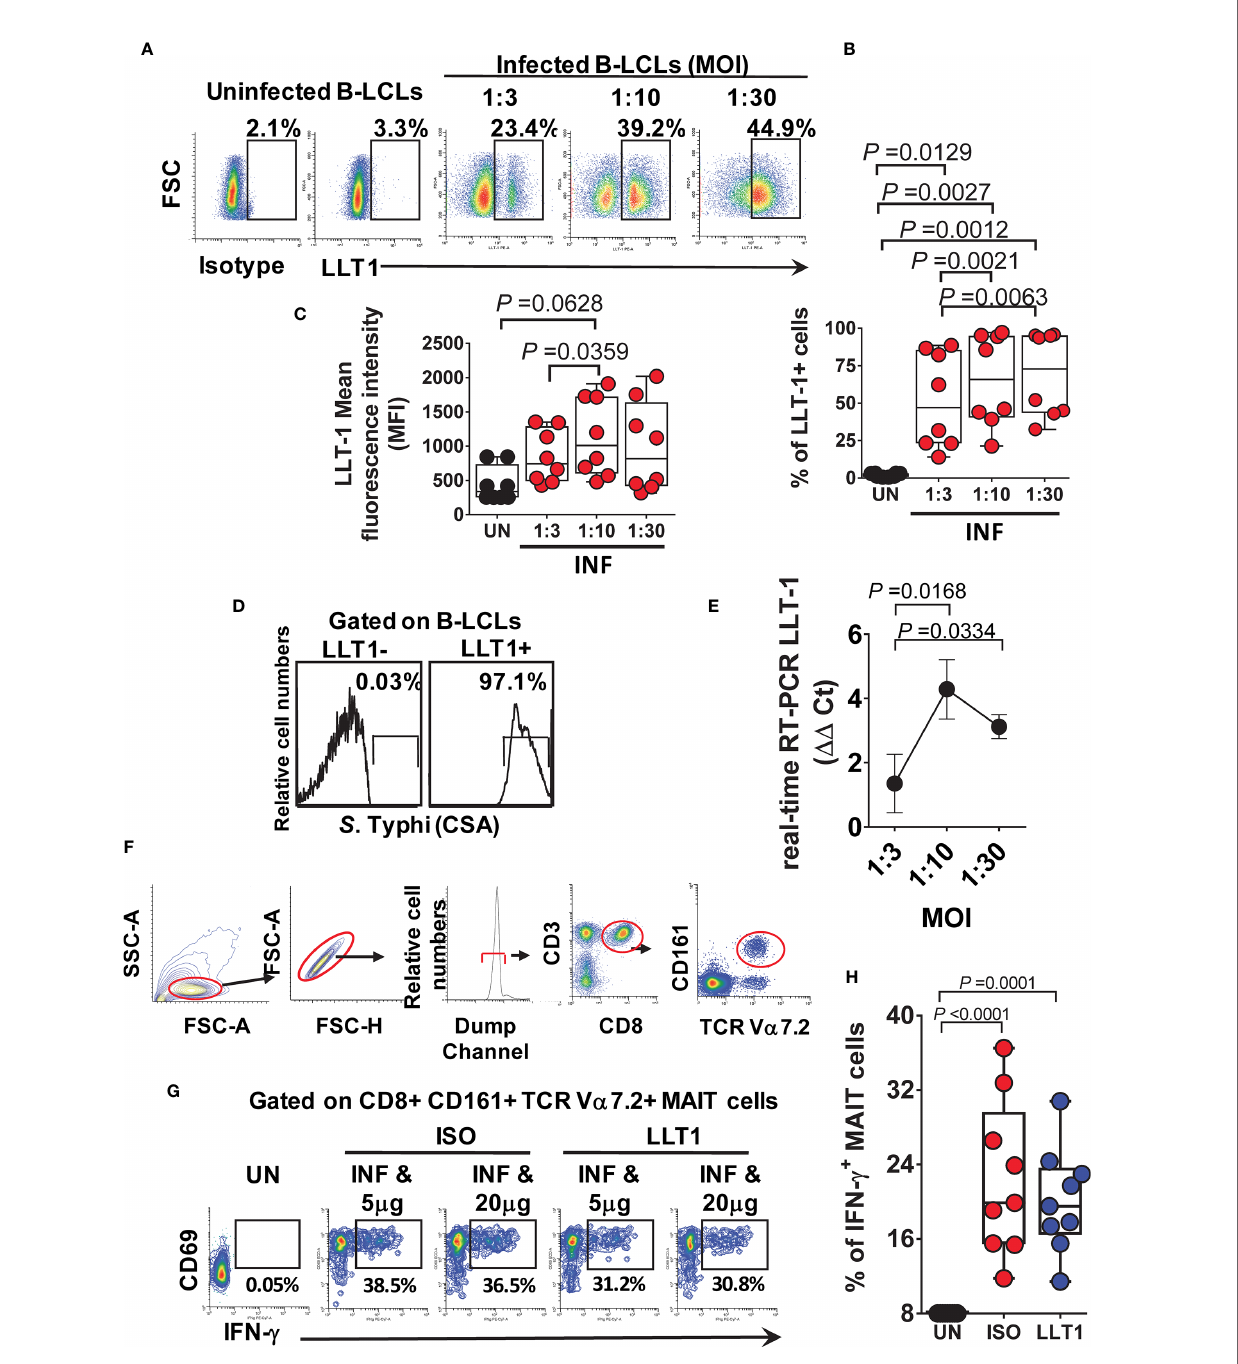
FIGURE 1 | Effect of LLT1 expression on MAIT cell function. B-LCLs were infected with S . Typhi for 3 hours. Uninfected cells were used as controls. After 16-18 hours of gentamicin treatment, cells were stained with anti-LLT1 Ab and analyzed by fl ow cytometry. (A) Percentage of LLT1 on the surface of B-LCL cells. Cumulative LLT1 (B) percentage and (C) mean fl uorescence intensity (MFI). Bar graphs extend from the 25 th to 75 th percentiles; the line in the middle represents the median of the pooled data. The whiskers delineate the smallest to the largest value. (D) S . Typhi infection levels in live LLT-1- and LLT1+ B-LCLs. (E) real-time RT- PCR for LLT-1. Data are representative of one independent experiment with 4 volunteers, three replicates each. (F) Representative gating strategy. (G) PBMC were exposed to either uninfected (UN) or S . Typhi-infected (INF) B-LCLs treated with different concentrations of Abs to LLT1 (LLT1) or isotype (ISO) control (5 and 20 m g/ml). After 16-18 hours of co-culture, cells were collected, and the levels of IFN- g expressing MAIT cells were evaluated by fl ow cytometry. (H) Cumulative data of IFN- g + MAIT cells after LLT1 blocking. Data are representative of two independent